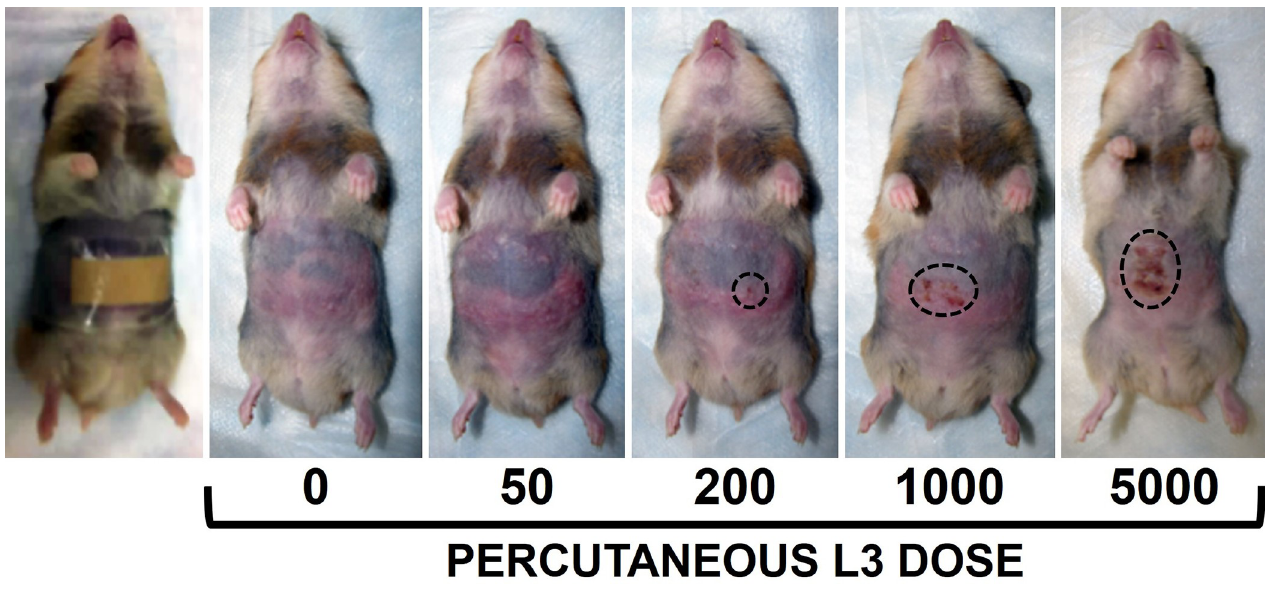
Fig 1. Representative photographs of hamsters following percutaneous infection, Experiment 1. Left panel shows the application of larvae to the abdominal area using an adhesive bandage as described in the Materials and Methods. Remaining panels show animals two days after infection with the indicated number of hookworm larvae. Dotted lines indicate extent of skin reaction to larval